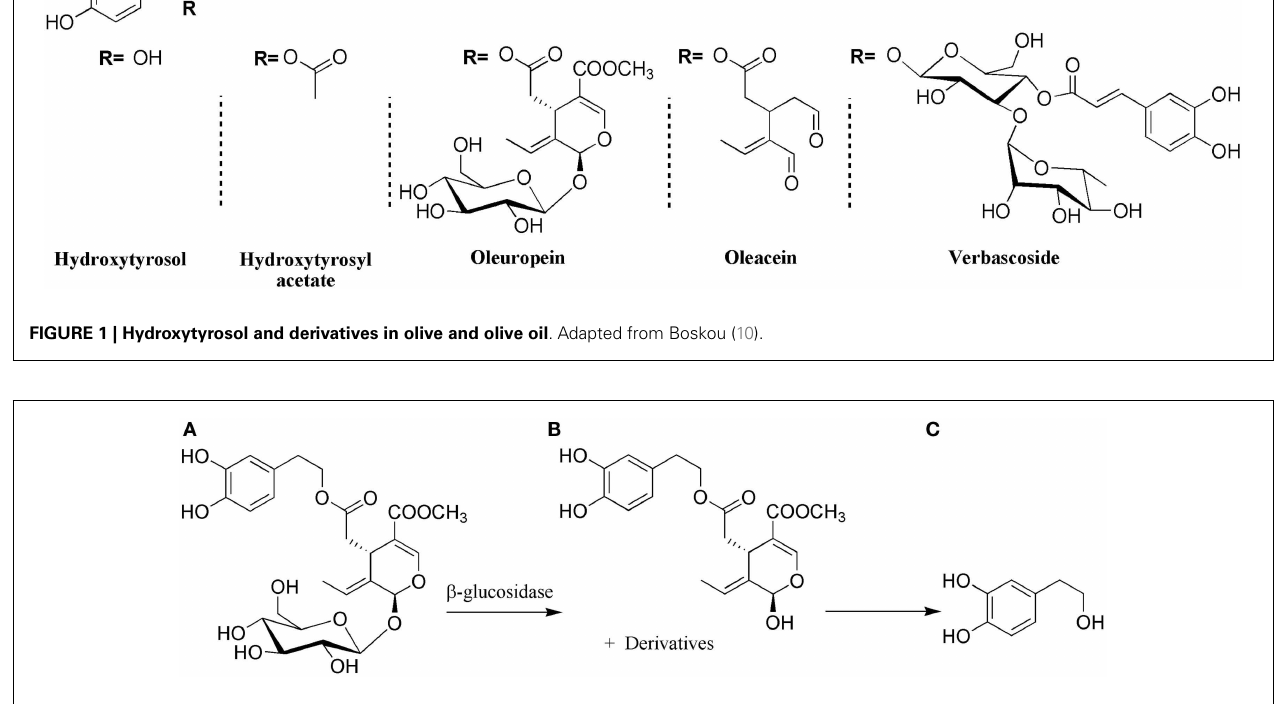
FIGURE 2 | (A) Oleuropein-glycoside ripening olives and olive oil. (B) Oleuropein-aglycone. (C) Hydroxytryosol. Adapted from Charoenprasert et al.